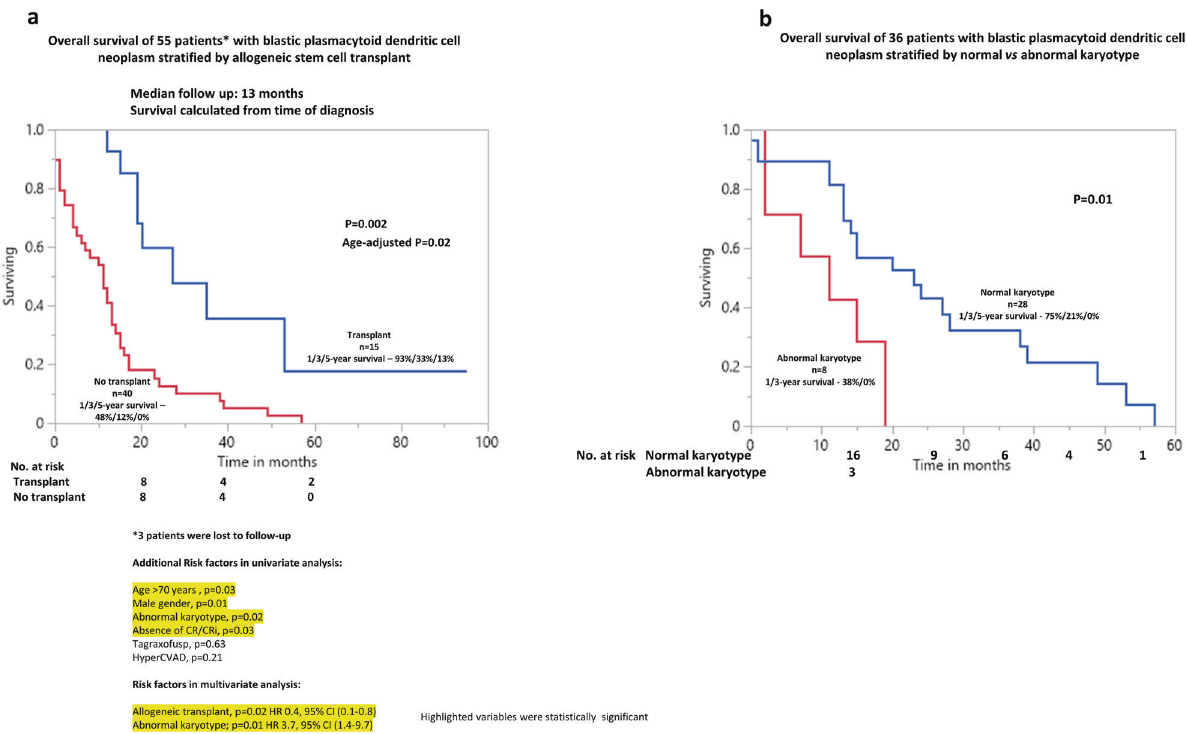
Fig. 1 Overall survival of Mayo Clinic patients with blastic plasmacytoid dendritic cell neoplasm. a Overall survival of 55 patients with blastic plasmacytoid dendritic cell neoplasm strati fi ed by allogeneic stem cell transplant. b Overall survival of 36 patients with blastic plasmacytoid dendritic cell neoplasm strati fi ed by normal vs abnormal